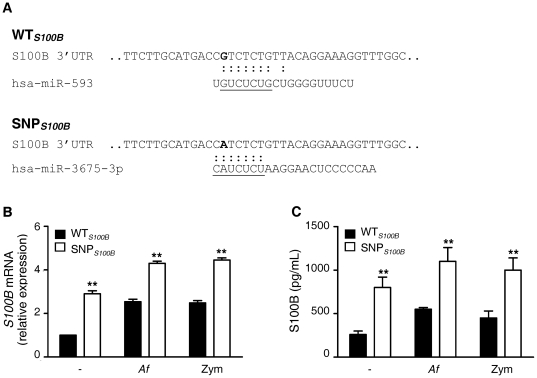
Functional consequences of S100B +427C/T polymorphism.(A) In silico search for miRNAs targeting S100B in the vicinity of the polymorphism. Putative binding sites for miR-593 in WTS100B and miR3675-3p in SNPS100B sequences are shown. Underlined sequences indicate ‘‘seed” sequences. (B) Analysis of S100B mRNA expression or (C) protein secretion in WTS100B (wild-type, CC genotype) or SNPS100B (CT genotype) PBMCs either left untreated or stimulated with A. fumigatus conidia (Af) and Zymosan (Zym). Data are shown as mRNA relative expression using untreated WTS100B cells as reference or as absolute quantity of S100B in culture supernatants (for every assay, shown is the mean±SD of data obtained for 10 individuals of each genotype; **P≤0.01 by unpaired t-test). Cells from the same individuals were used across conditions in each assay.